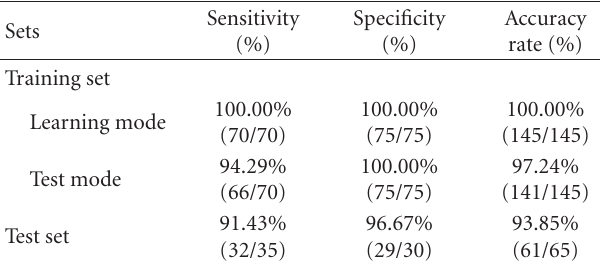
Table 3: Performance of the classification tree analysis of node- positive CRC patients in training set and test